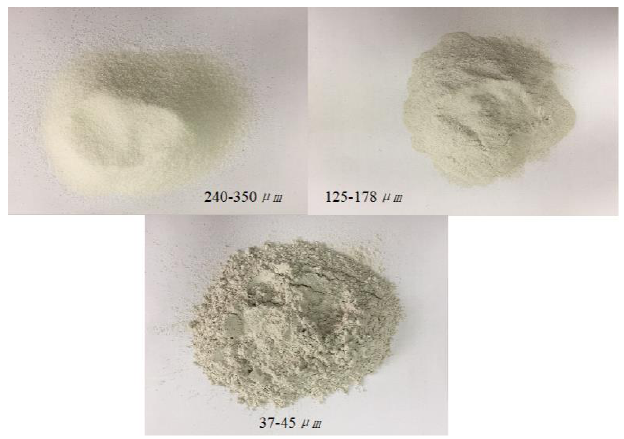
Figure 3. Experimental sediment.